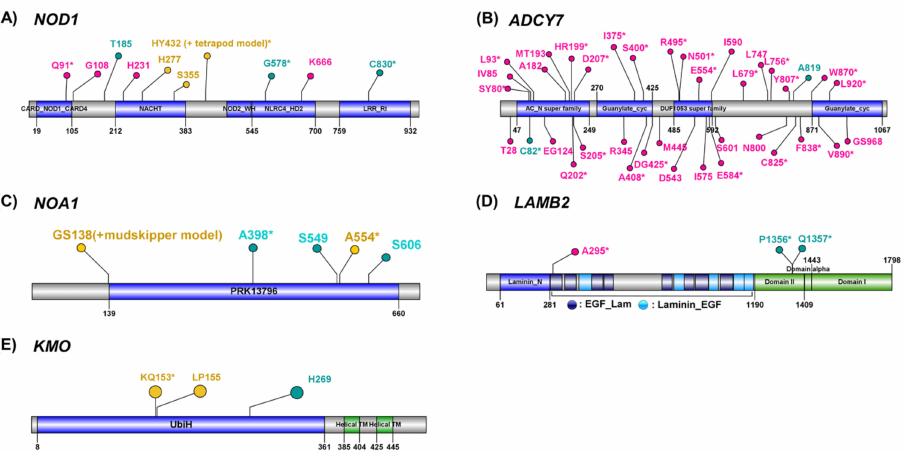
Figure 3. Positively selected amino acid substitutions in functional domains. Labels with the amino acid residue and the position of positively selected TAAS site of target species were annotated (yellow, red, green: a positively selected site detected from tetrapod-and-mudskipper model, tetrapod model, or mudskipper model, respectively). A label with asterisk indicates EAASPS (exclusive amino acid substitution under positive selection). Blue and green bars indicate domains or regions predicted by NCBI conserved domain search [42] or from UniProt [43],